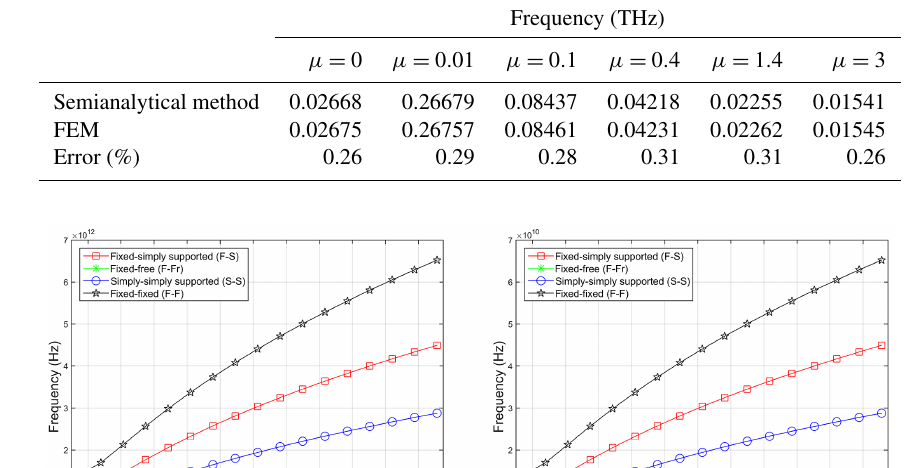
to D = 2 . 712 nm. The length of considered CNTs